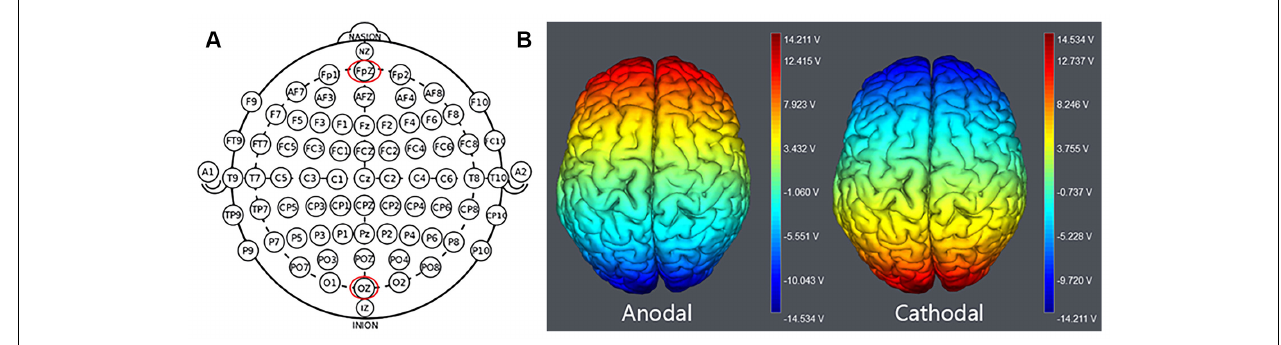
while the cathodal electrode (5 cm ∗ 7 cm) was placed over the Oz. The anodal electrode (5 cm ∗ 7 cm) was placed over Oz, while the cathodal electrode (3 cm ∗ 3 cm) was placed over Fpz to achieve cathodal stimulation ( Figures 1A,B ).